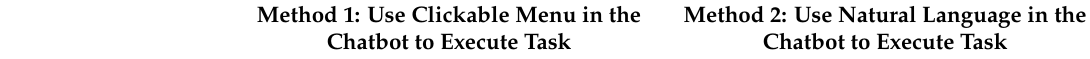
Table 3. Designed tasks for the feasibility test. Method 1: Use Clickable Menu in the Chatbot to Execute Task Chatbot to Execute